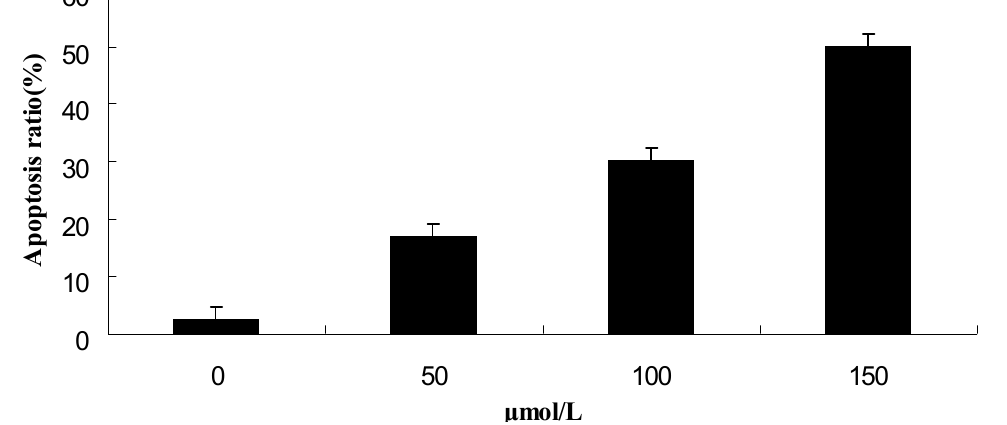
Figure 4. Results of the flow cytometry